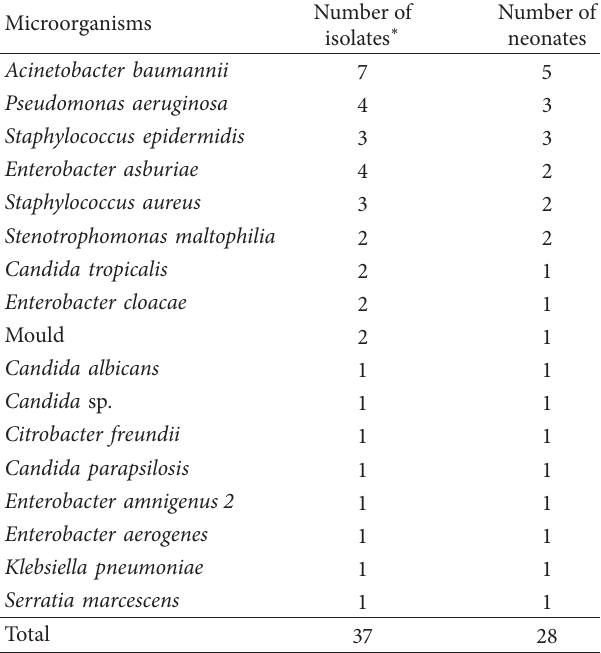
Table 1: Spectrum of microorganisms isolated from blood culture of neonates with